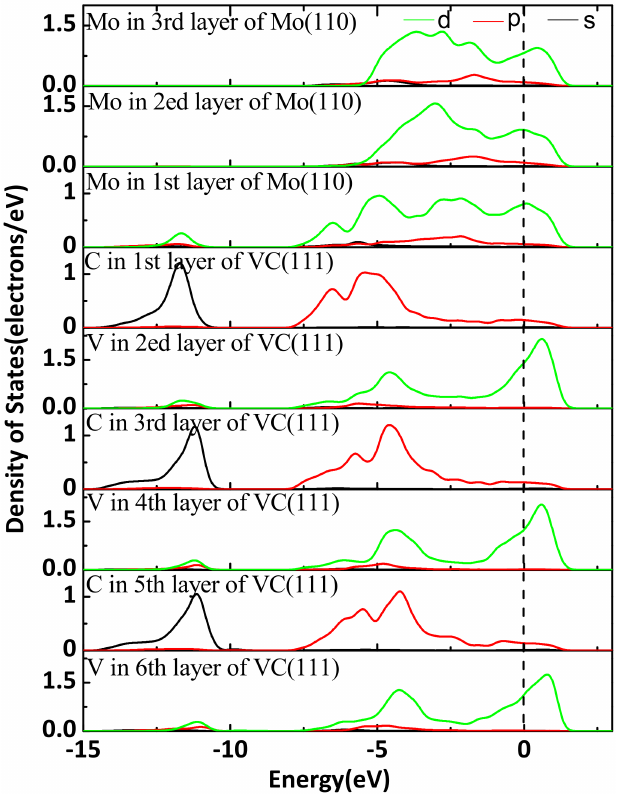
Figure 10. PDOS of C-terminated hollow-site interface (The vertical dash line indicates the Fermi